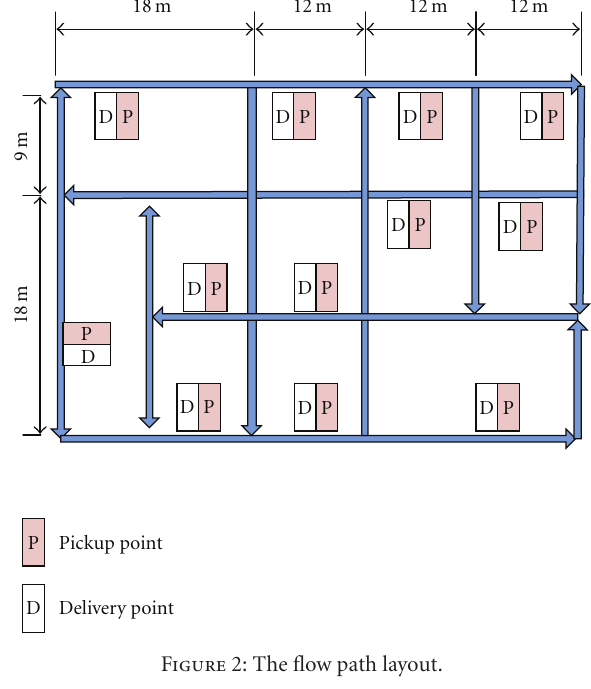
Figure 2: The flow path layout.